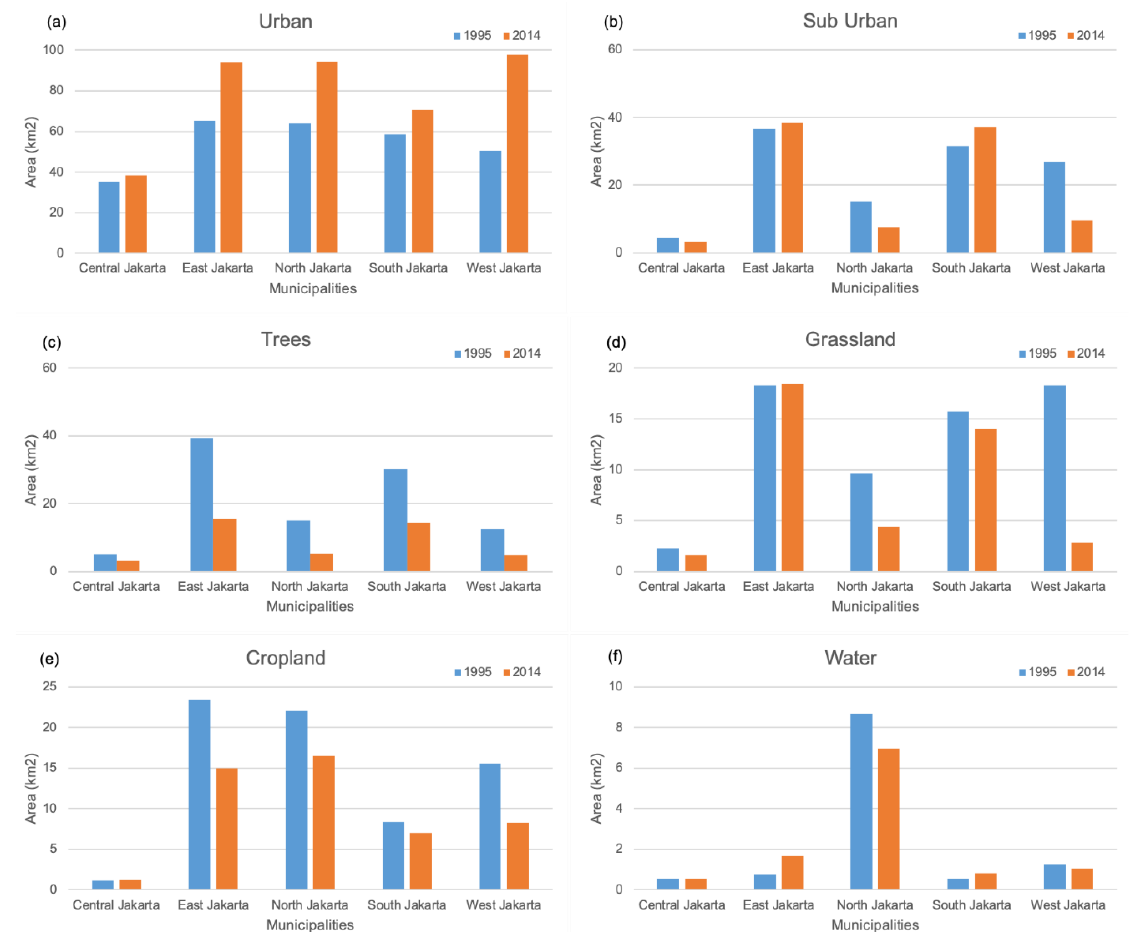
Figure 4. The area of land use–land cover of Jakarta in 1995 and 2014. ( a ) The area of urban class; ( b ) the area of suburban class; ( c ) the area of trees; ( d ) the area of grassland; ( e ) the area of cropland; ( f ) the area of bodies of water.